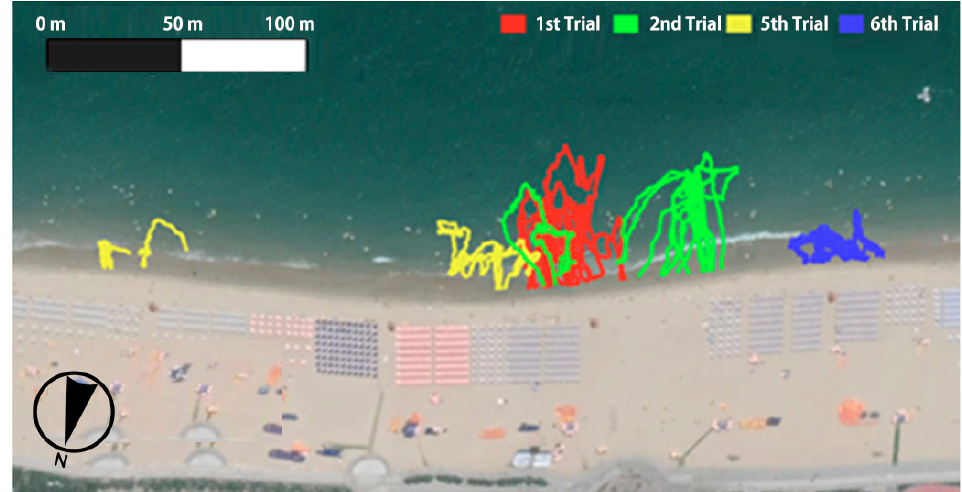
Figure 7. GPS drifter survey location and tracking (background image obtained from Google Earth [6]).